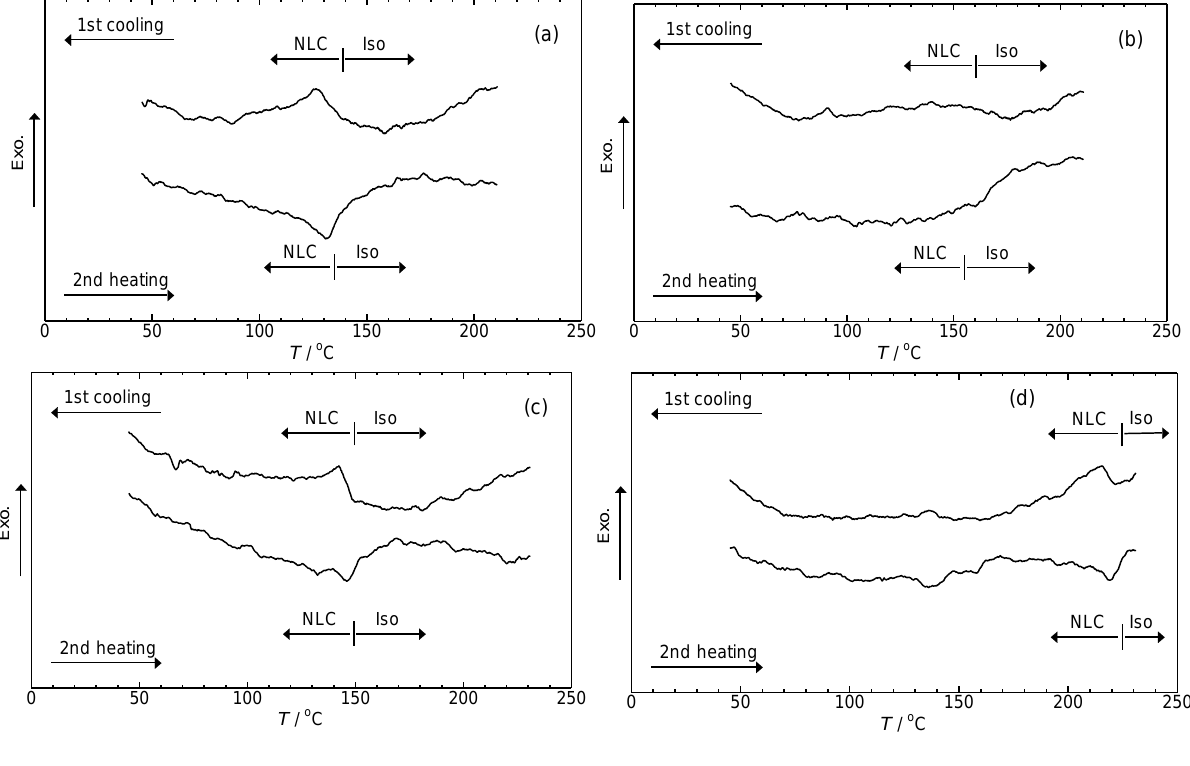
Figure 8. DSC curves of P1T (a) , P2T (b) , P1LC (c) , and P2LC (d) .